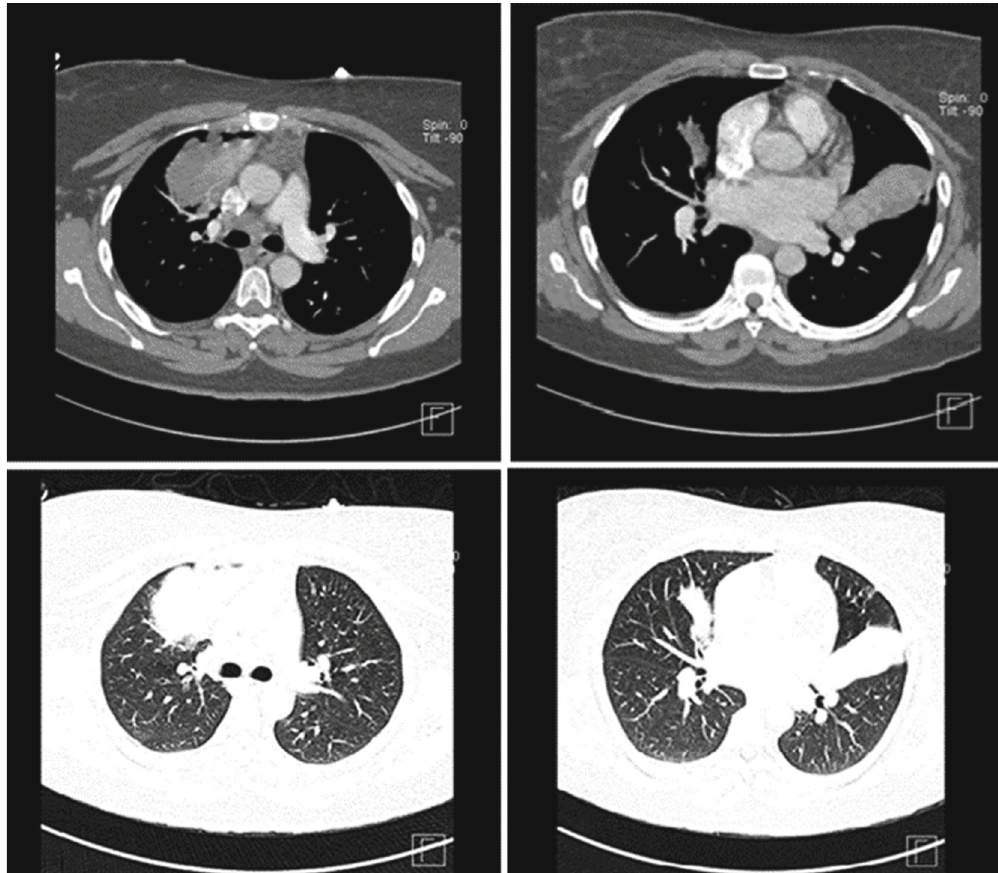
Figure 2: Computed tomography pulmonary angiography shows bilateral mass-like density with fi nger in glove